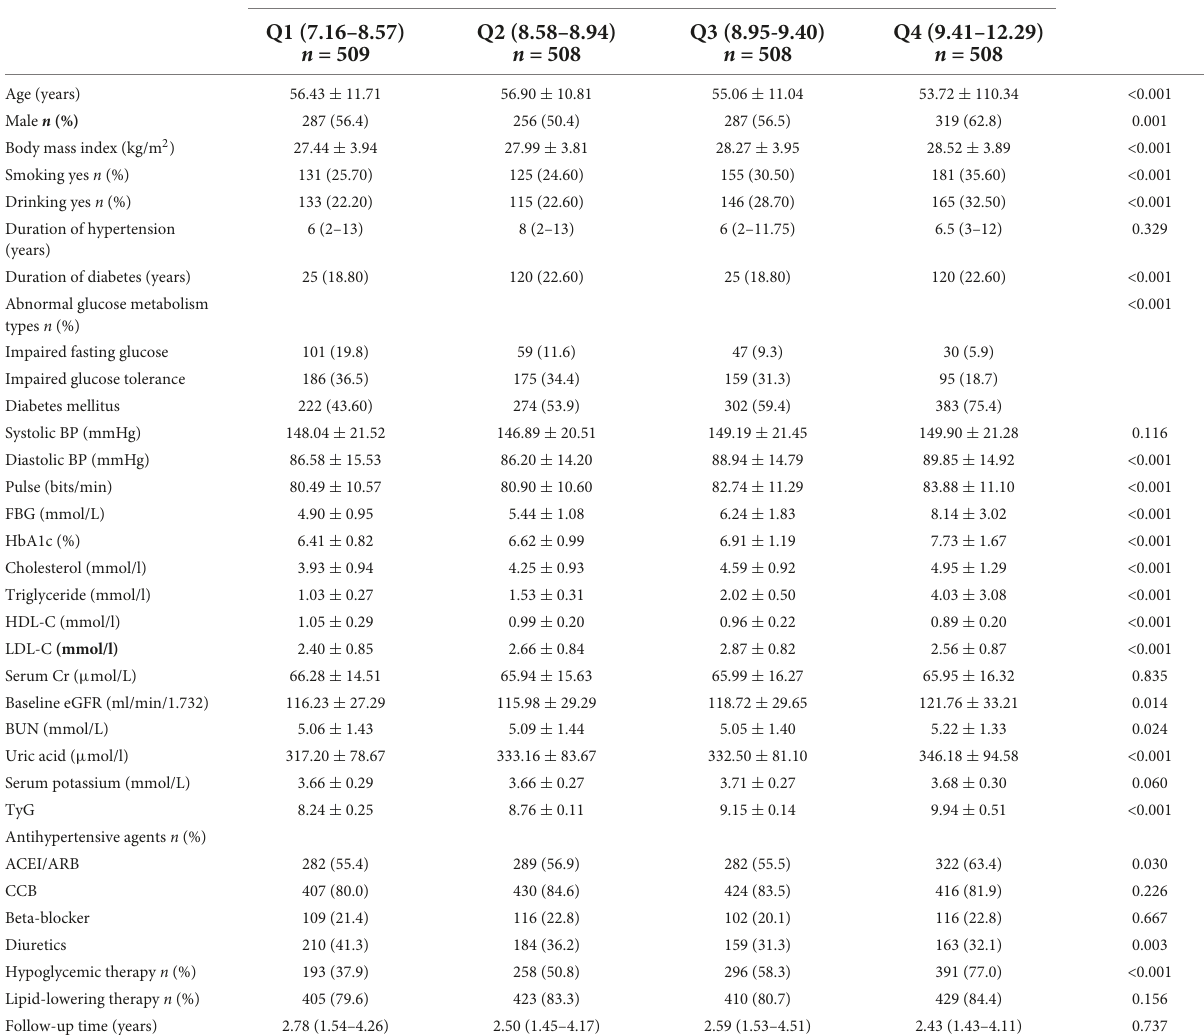
TABLE 1 Baseline characteristics of participants according to quartiles of TyG